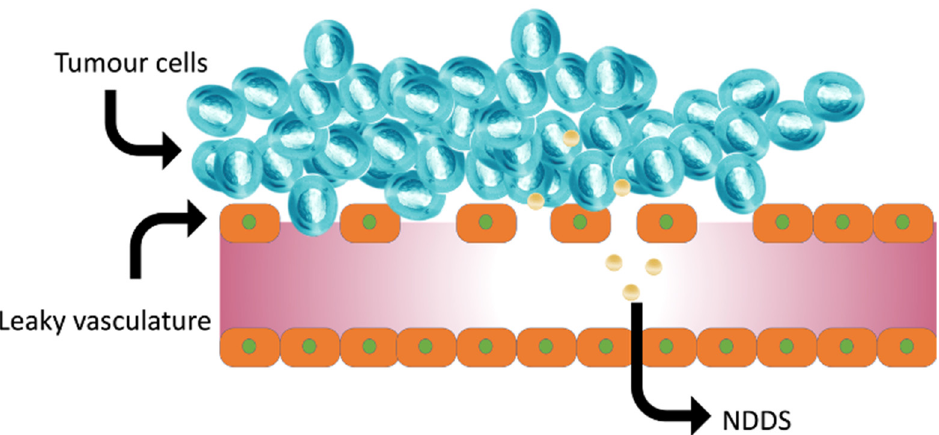
Figure 13. Schematic presentation of passive drug targeting and enhanced permeability and retention effect (EPR) in tumor tissue. The passive targeting of NDDS to tumors occurs through the spaces between endothelial cells, and a decrease in lymphatic drainage improves this accumulation.